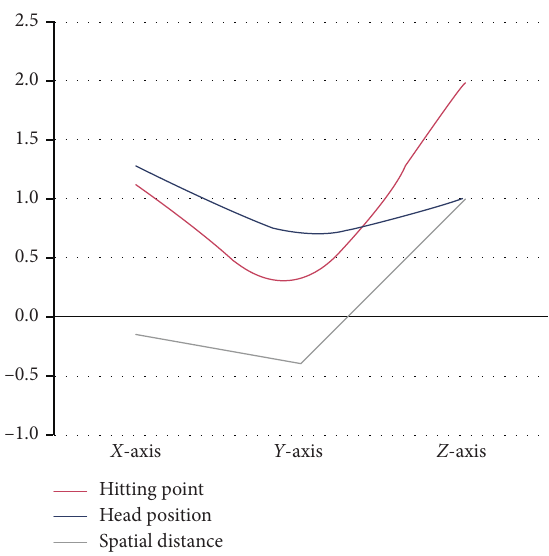
Figure 13: Statistical diagram of the three-dimensional distance between the hitting point and the head space position of the flat strike (unit: m). Table 8: The three-dimensional distance between hitting point and head space position of the top spin (unit: m).